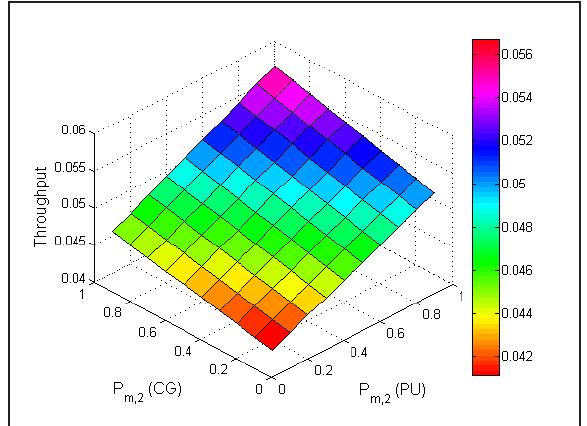
Figure 6. Effect of false alarm probability of CG and PU on the Throughput of CRN